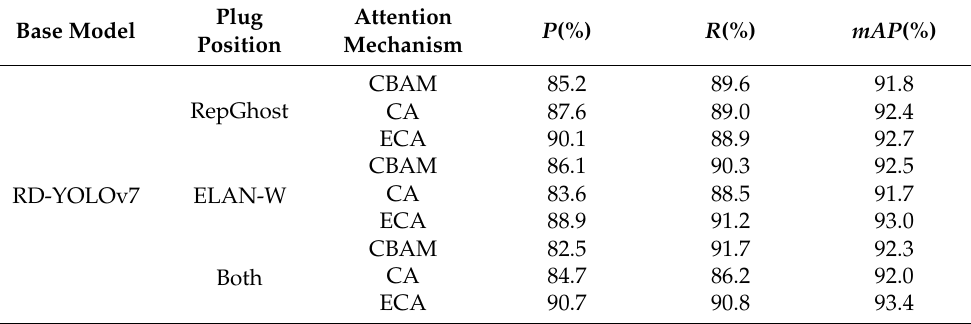
Table 7. Experiment results of different attention mechanisms in different positions.